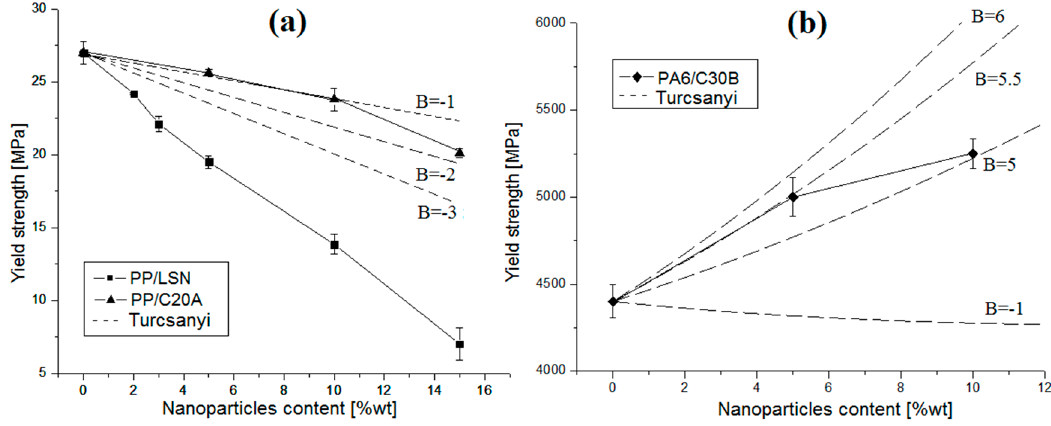
Figure 8. Yield strength of nanocomposites: ( a ) PP/LSN and PP/C20A; and ( b ) PA6/C30B.